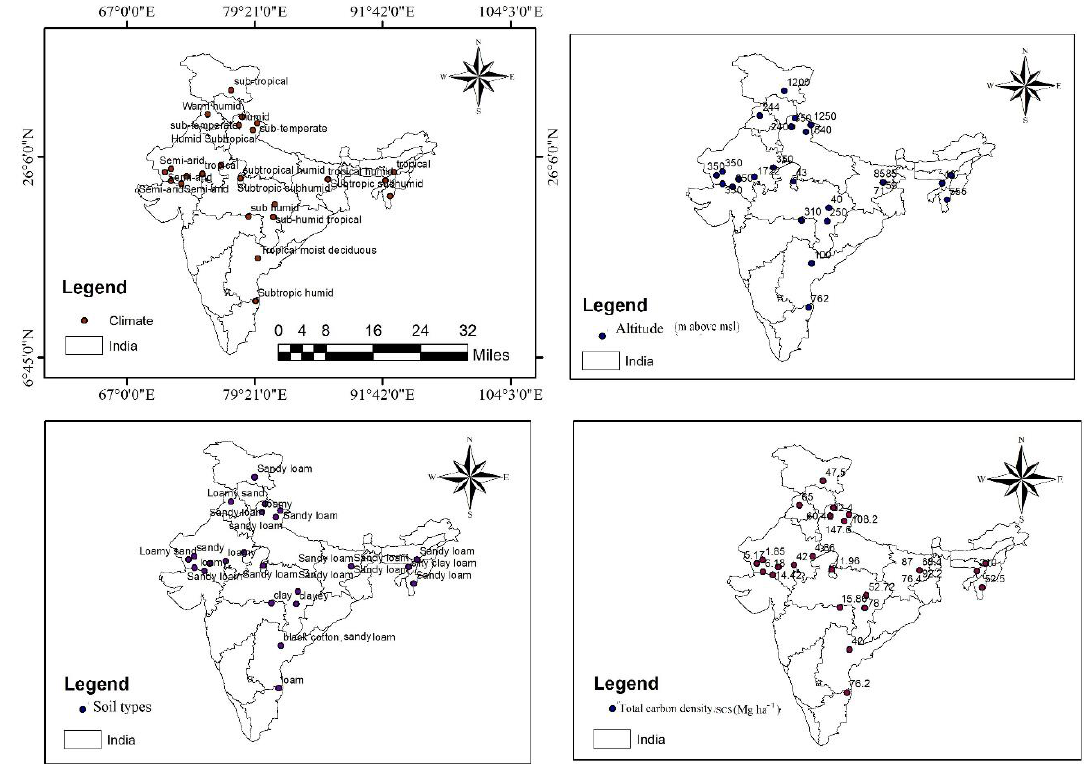
Figure 2. Location map of the major study areas showing climate, altitude, total carbon density / soil carbon stocks (SCS) and soil types in a clockwise direction.